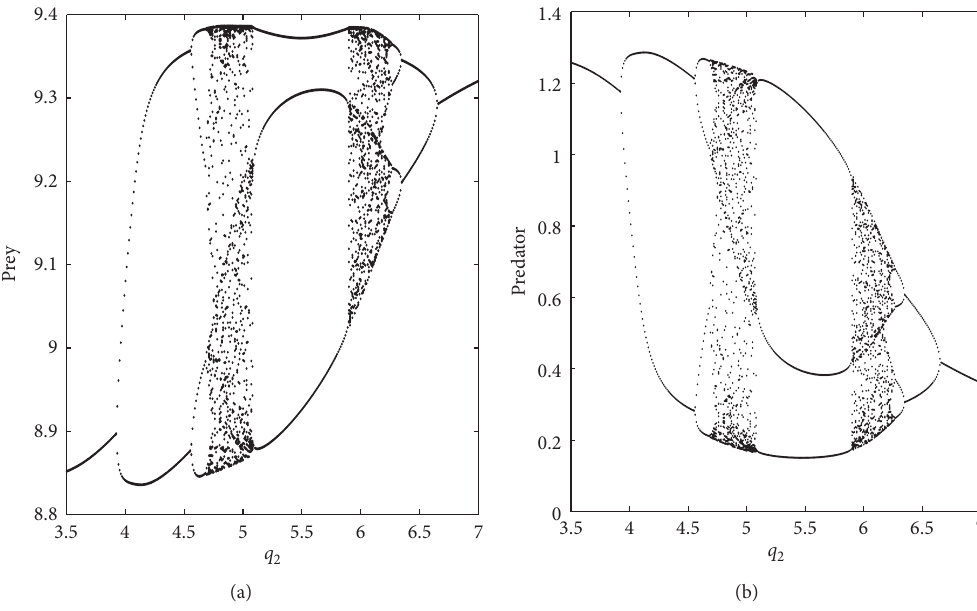
. Parameter values are 2